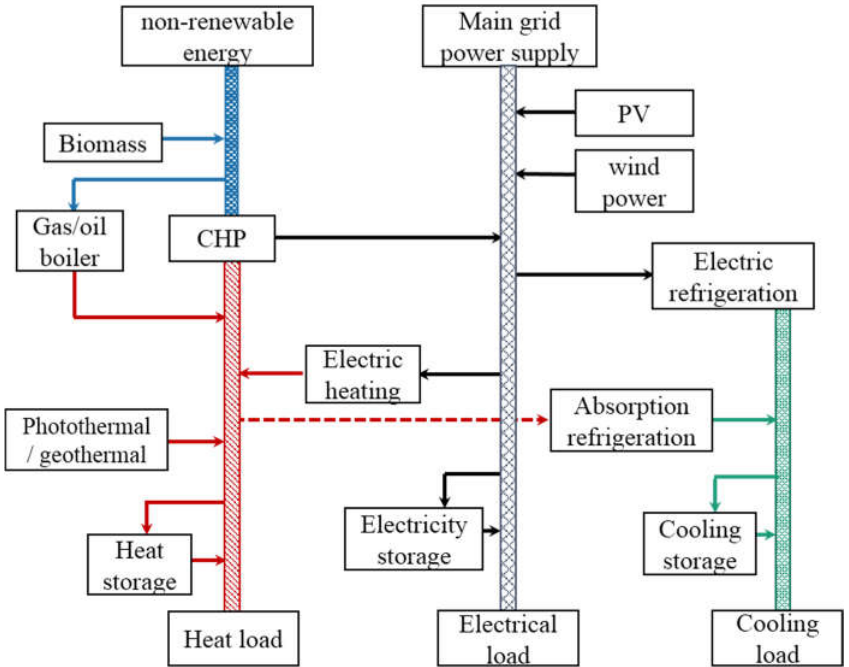
Figure 3. Physical structure description of the standardized matrix model for the integrated energy system.